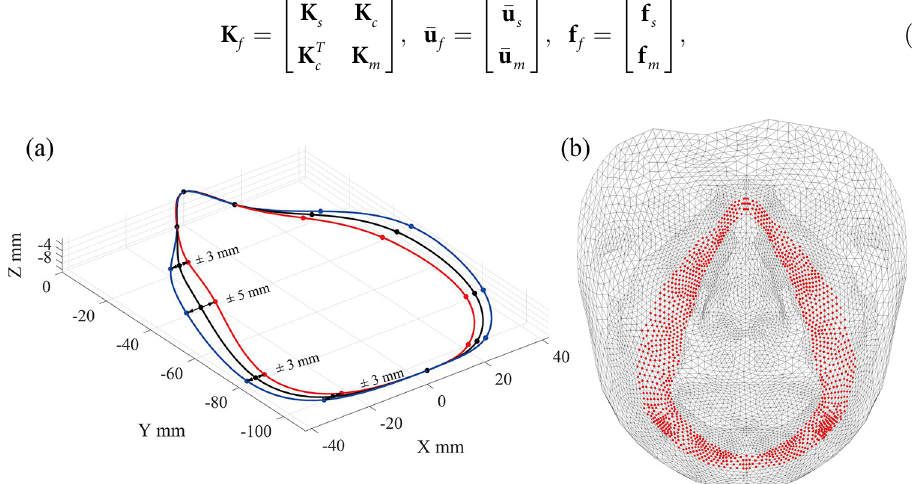
Fig 5. (a) Variation of the mask design and (b) the complete set of the master nodes that cover the variation of the mask design.